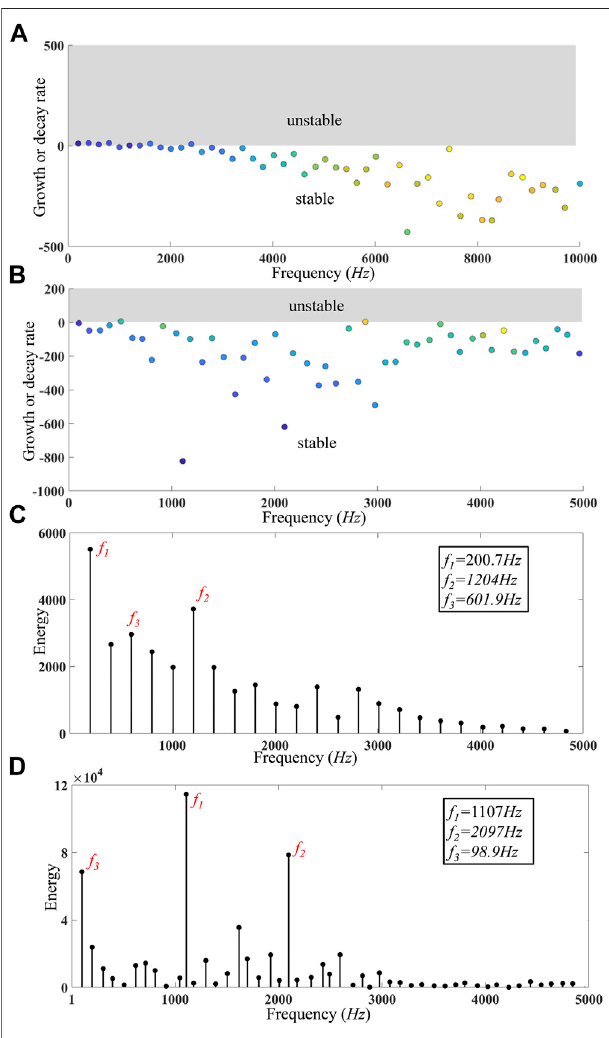
FIGURE 15 | Frequency spectra and the energy distribution of the CS and PS con fi gurations. (A) Frequency spectra for the CS con fi guration; (B) frequency spectra for the PS con fi guration; (C) energy distribution for the CS con fi guration; (D) energy distribution for the PS con fi